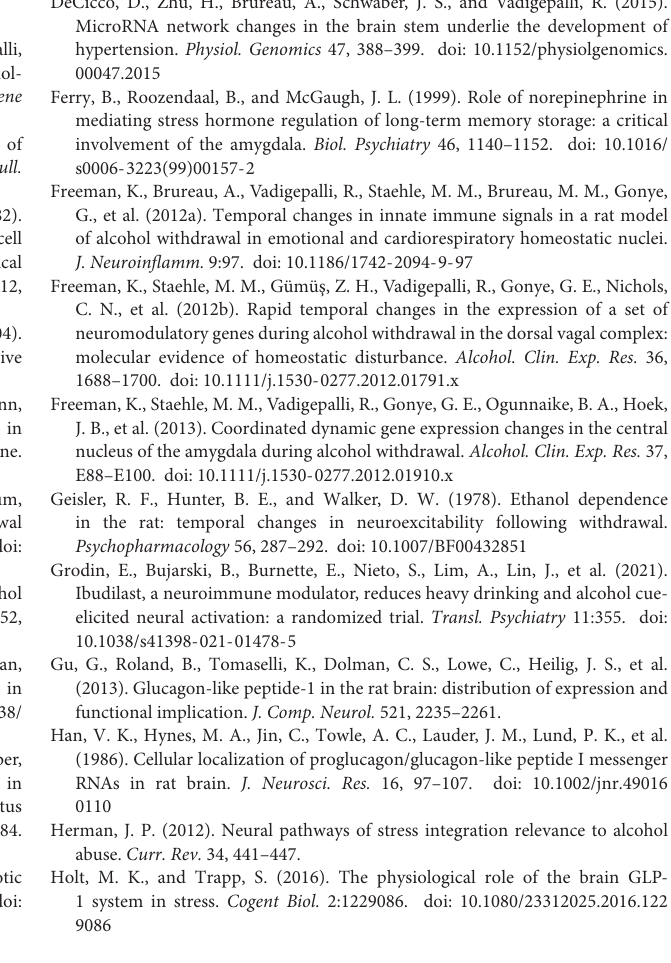
Supplementary Figure 3 | Technical replicate plots of raw Ct values. Supplementary Figure 4 | Inter-batch replicate plots of raw Ct values. Supplementary Figure 5 | Inter-batch replicate plots of raw Ct values. Supplementary Figure 6 | Suphenotype gene expression in NE and GLP-1 neurons. Cellular cartoons display boxes representing relative gene expression (average z-score of − (cid:49)(cid:49) Ct values) of subphenotypes shown in prior heatmaps. Legend on right labels which boxes correspond to which gene and the color that represents expression (blue is low expression and yellow is high expression). The location of the box represents the localization or function of the protein product from that gene transcript. Legend is shown in gray boxes with labels. Supplementary Figure 7 | Schematic of opponent-process model of addiction. Originally published in O’Sullivan and Schwaber (2021). (A) Alcohol and/or opioid exposure has two actions: Stimulate reward, via the mesolimbic dopamine pathway, and inhibit antireward. These actions motivate substance use via positive reinforcement. (B) Alcohol and/or opioid withdrawal has two action. Inhibit reward, by inhibiting the mesolimbic dopamine pathway (not shown), and stimulate antireward. This study proposes that visceral-emotional neuroinflammation is an endpoint in antireward stimulation, though this hypothesis warrants further testing. These actions, whatever the mechanism, motivate substance dependence via negative